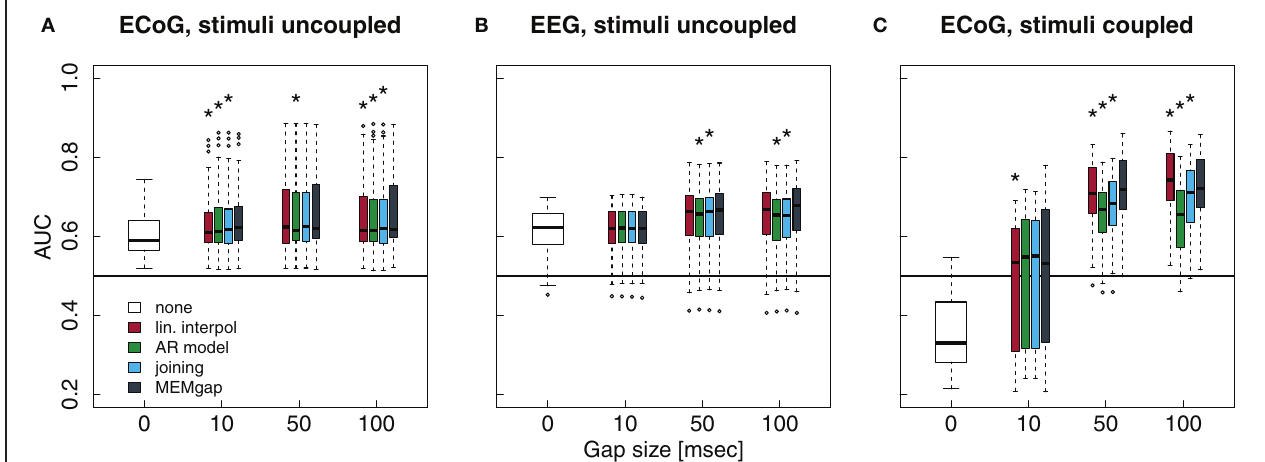
FIGURE 9 | Influence of the stimulation processing algorithm and gap size on the separability between intended movement and rest for experiments with stimulation. No processing of the stimulation after-effects was conducted for a gap size of 0. For gap sizes of 10, 50, and 100, AUC values were calculated after application of the four algorithms (boxes from left to right) real interpol , AR model , joining , and MEMgap . A baseline AUC value of 0.5 is shown as a solid line, because this is the chance level for a purely random classifier (Fawcett, 2006). (A) Average AUC values for the separation of movement and rest from experiments with epidural